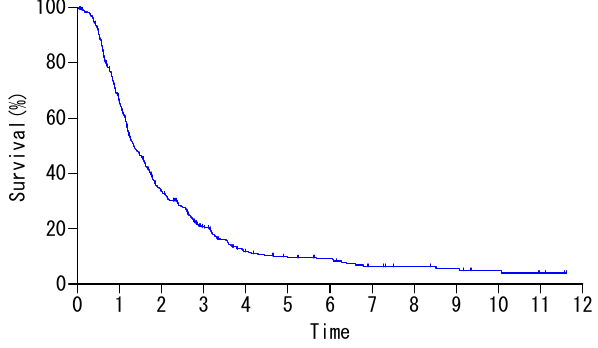
Figure 1. Overall survival of 419 patients.